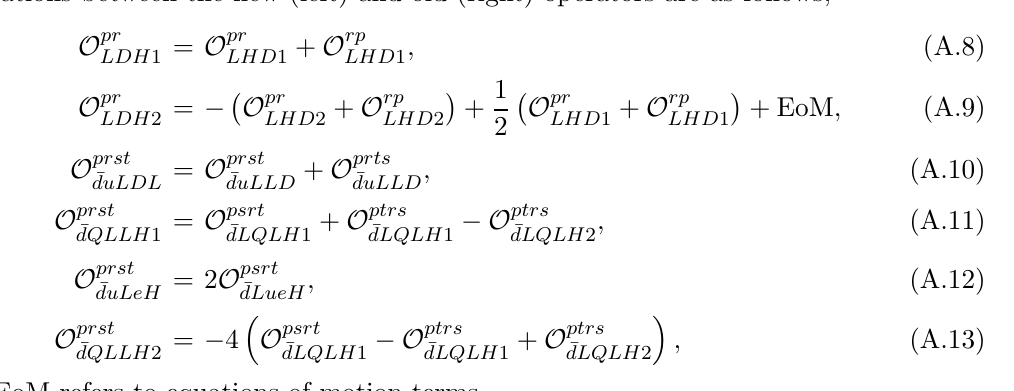
The relations between the new (left) and old (right) operators are as